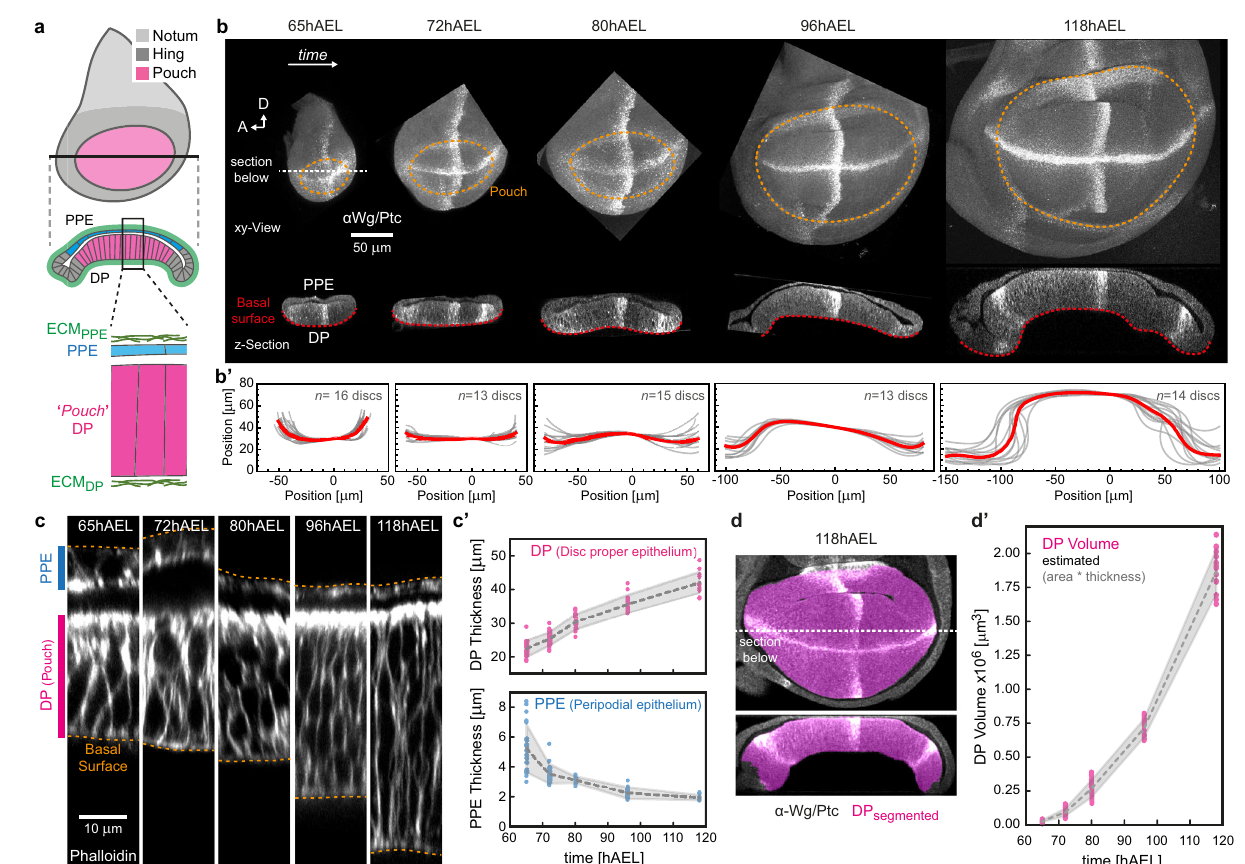
Fig. 1 | Growth-associated epithelial doming and thickening. a Scheme of the Drosophila wing disc:The discproper epithelium(DP) isoverlaid by the peripodial epithelium (PPE, blue).The DP contains the wing pouch(magenta), surrounded by the hinge (dark grey). The disc is covered by an ECM shell (green). The scheme is adaptedfromref. 79 ,licensedunderCCBY4.0. b Wingdiscsofindicatedage(given inhoursafteregglaying,hAEL)in-plane(top)andsectionview(bottom)stainedfor Wingless and Patched (Wg/Ptc) to provide landmarks and the tissue outline. Discs in-plane vieware oriented withanterior(A)facing leftanddorsal(D) facing up, the pouch is outlined by a dashed line. In section view the PPE is facing upwards. The basal surface of the DP is marked (red dotted line). b ’ Quanti fi cation of average